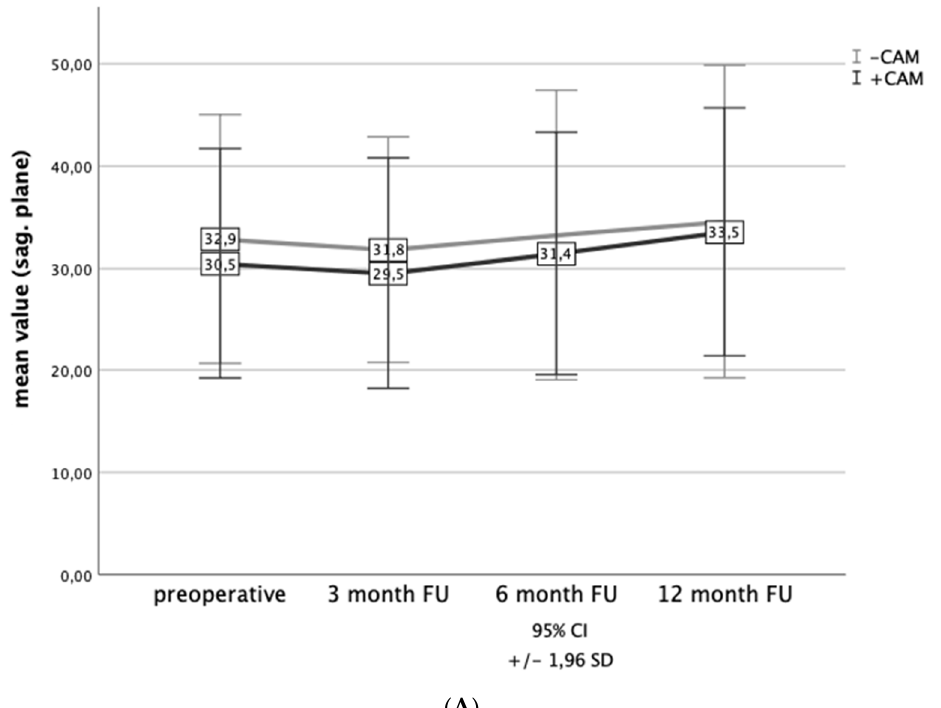
Comparison between the baseline values and the 12-month results in all planes showed a greater increase in the +cam group for the frontal plane, with statistical significance